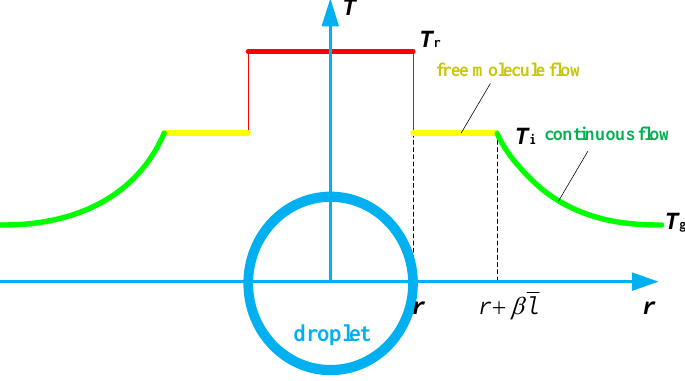
Figure 3. Temperature distribution of the droplets surrounding the environment in the Langmuir model.